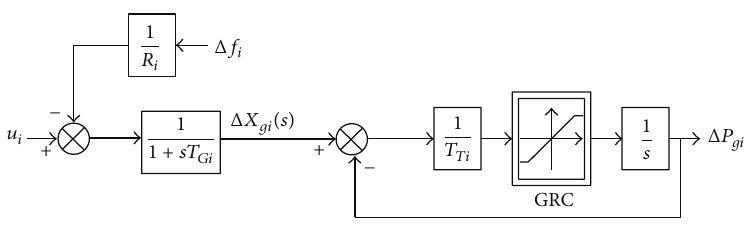
Figure 8: Thermal power plant with GRC.